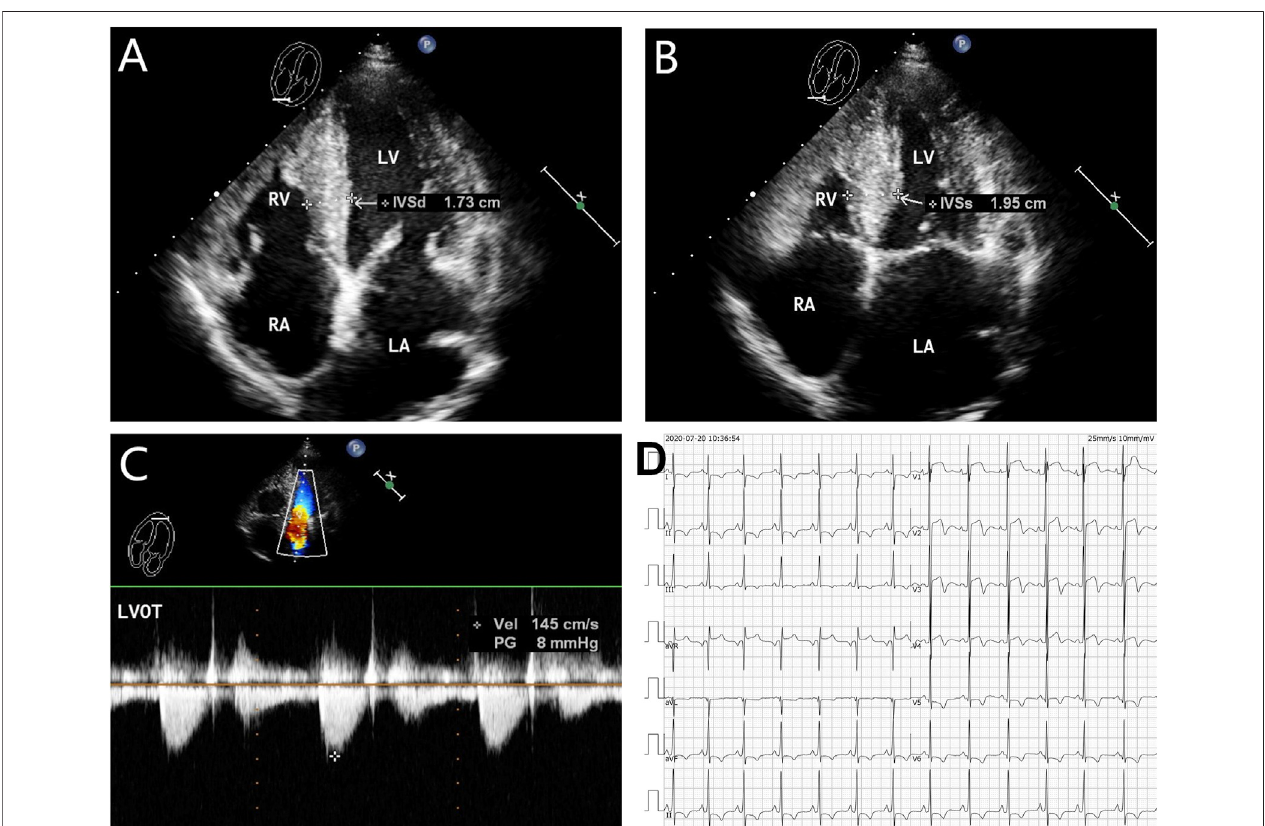
FIGURE 2 | Echocardiography and electrocardiography in the proband ( III-2 ). (A – C) Echocardiography and color Doppler showed enlargement of the left atrium, thickeningoftheinterventricularseptumattheend-diastole,andnoout fl owobstruction,EF67%. (D) ECGshowedthatinferiorandhighlateralwallleadstoST-segment depression with T-wave inversion; right precordial leads to ST-segment